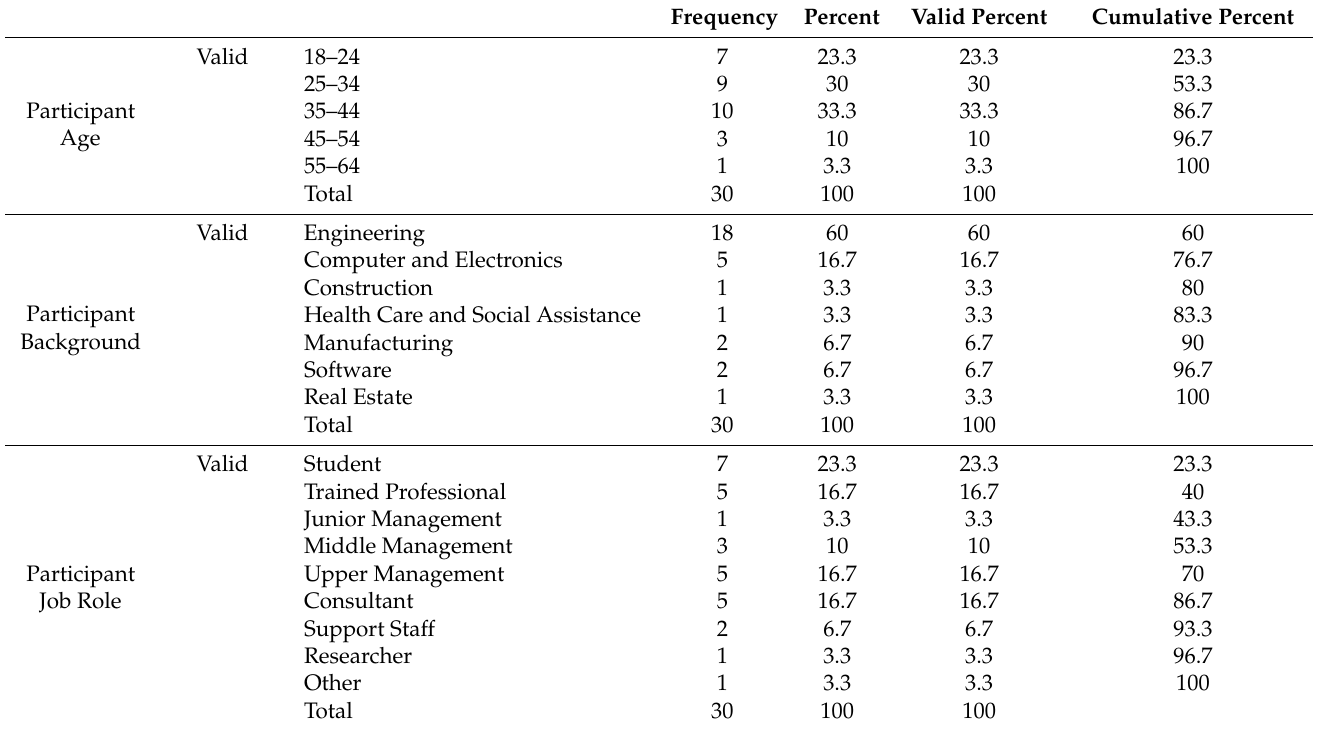
Table 3. Demographic analysis of the participants that took place in the